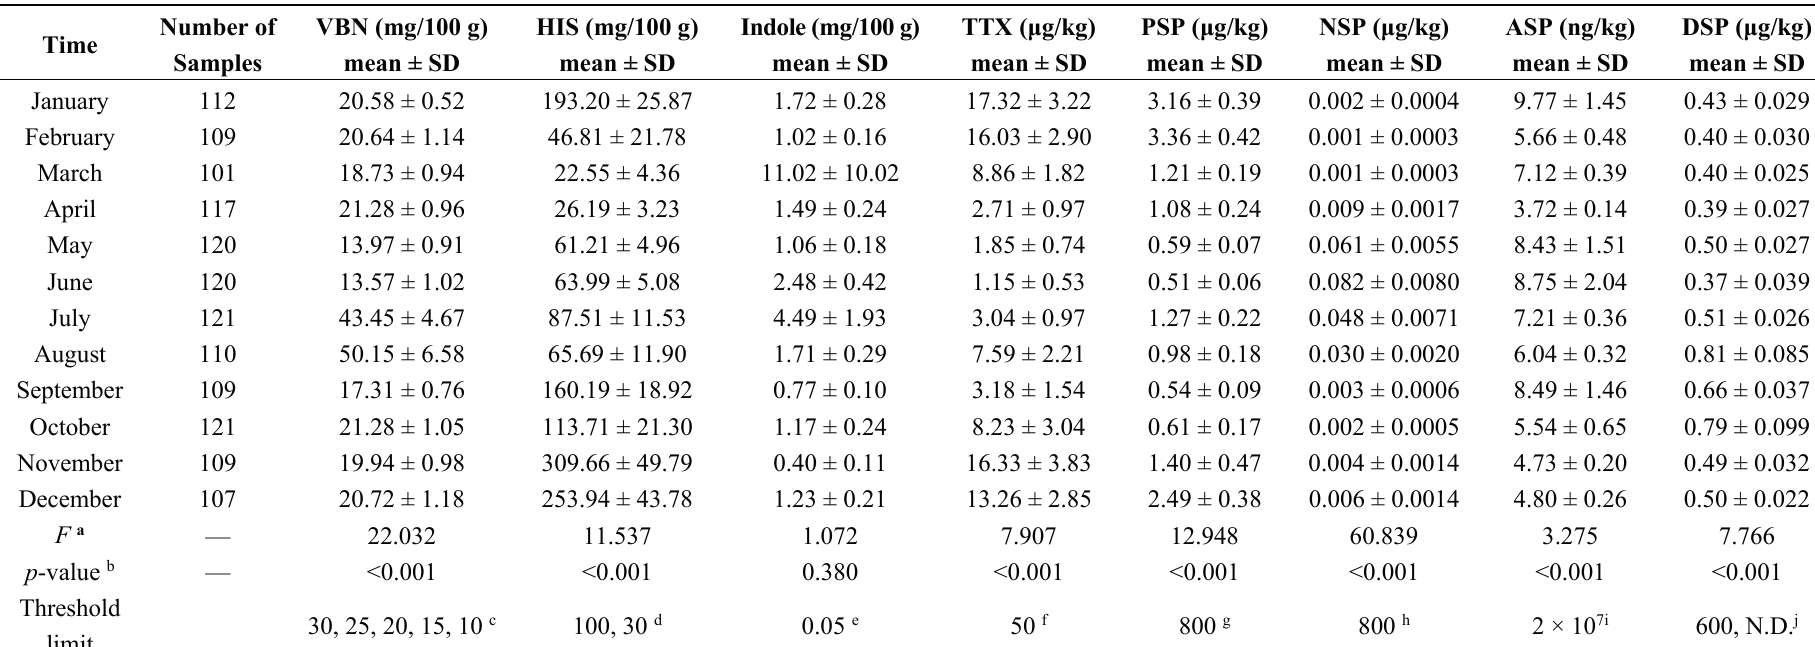
Table 1. Time statistical distribution of the different hygiene index values of live fresh aquatic